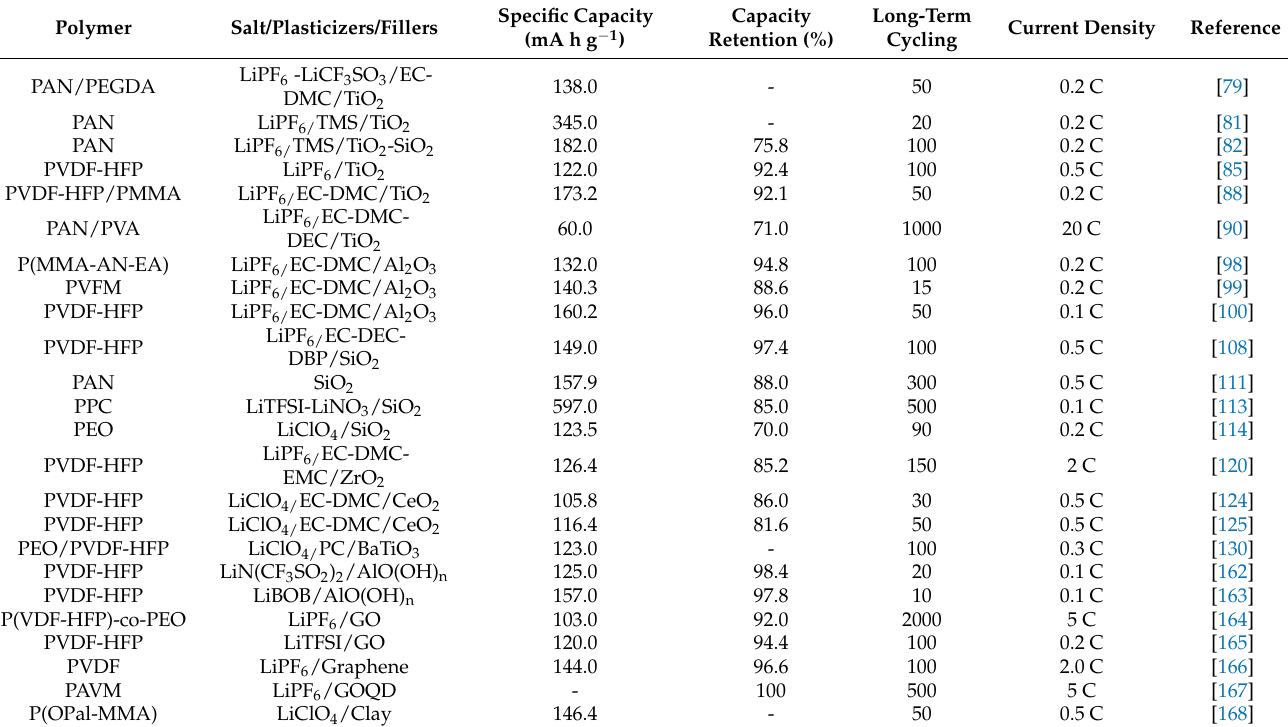
Table 7. Lists of GPEs and their electrochemical performance in lithium-ion batteries (LIBs). Polymer